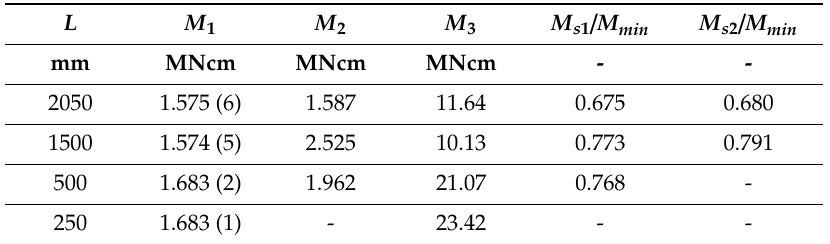
Table 2. The buckling moments M r with the corresponding number of half-waves m of buckling along the longitudinal direction of the LC-1 and the dimensionless ratio of load carrying capacities M s / M min for di ff erent lengths L .